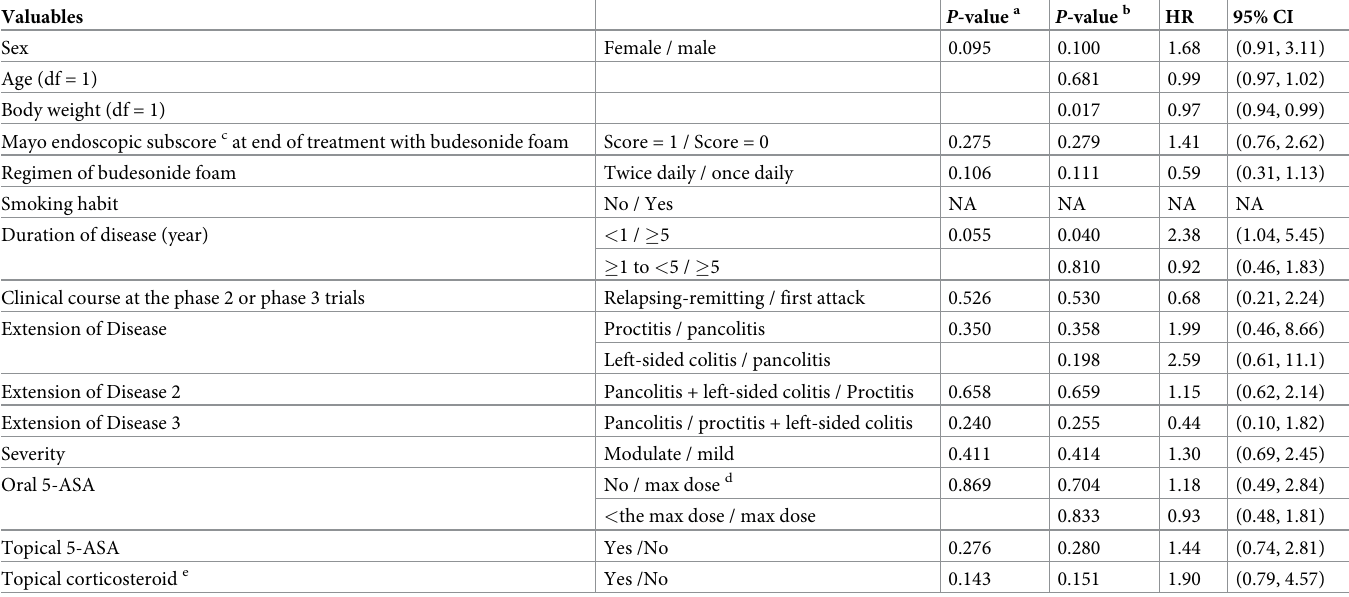
Table 3. Estimated hazard ratio (HR) with Cox regression